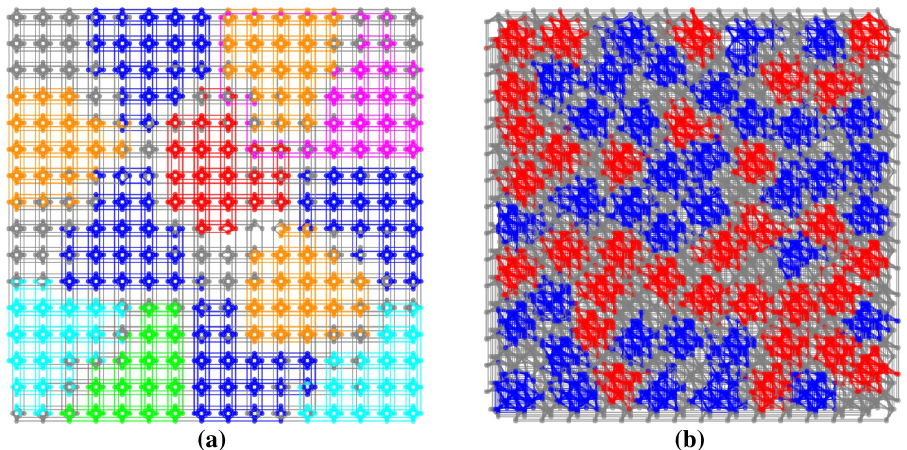
Figure 1. Clique of size 20 embedded 12 times into the hardware of DW 2000Q, which uses Chimera graph topology ( a ), and 68 times into DW Advantage, which has a Pegasus hardware graph ( b ). The coloring is arbitrary and used to highlight the separation of the different embeddings, with unused qubits and couplers in grey. Note that the actual embeddings do not make use of all of the physical couplers between the qubits used in the embedding; in theses figures we are showing the subgraphs induced by the qubits used in each